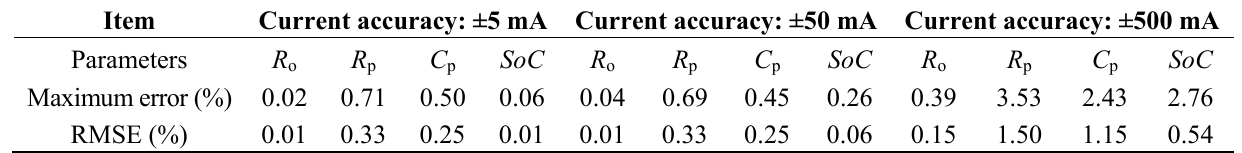
Table 8. The statistical error analysis of model parameters and SoC at the current sensor precisions of ±5/±50/±500 mA.